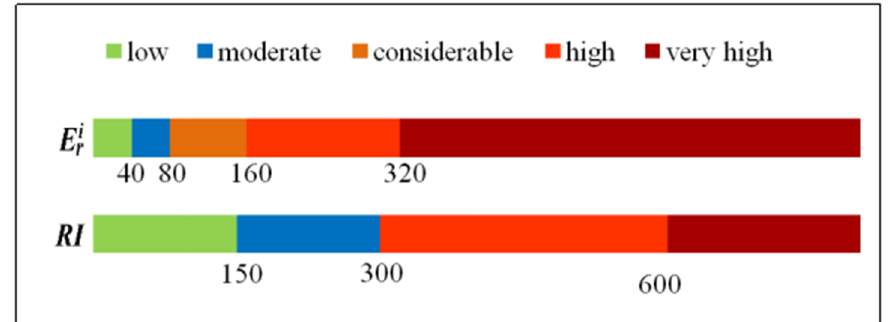
Figure 2. The degrees of E ri and RI of heavy metals.